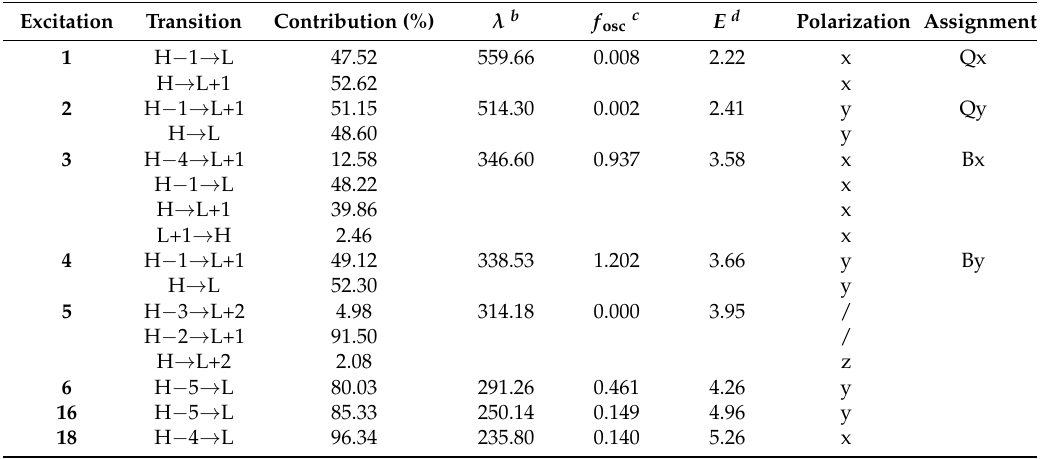
Table 3. Properties of the main electronic transitions of neutral unsubstituted (18)porphyrin ( 18P ) a . Excitation